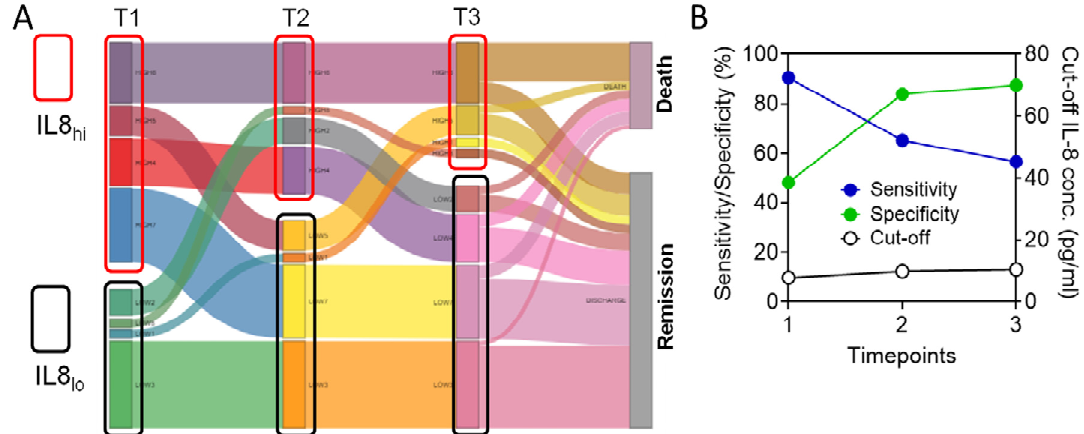
Figure 7. Plasma IL-8 dynamics parallel disease course and stratify final outcomes in severe COVID-19. ( A ) Sankey chart showing subgroups of severe COVID-19 patients variably falling into either IL8 hi or IL8 lo groups at three different time-points, stratified in terms of final outcomes. ( B ) Plot shows data from receiver operator characteristics analyses for plasma IL-8 levels at three time-points in terms of final fatal outcomes, showing the respective cut-off values (black line, right Y axis represented as percent) as well as sensitivity (blue line) and specificity (green line) for those cut-off values (left Y axis represented as plasma concentration of